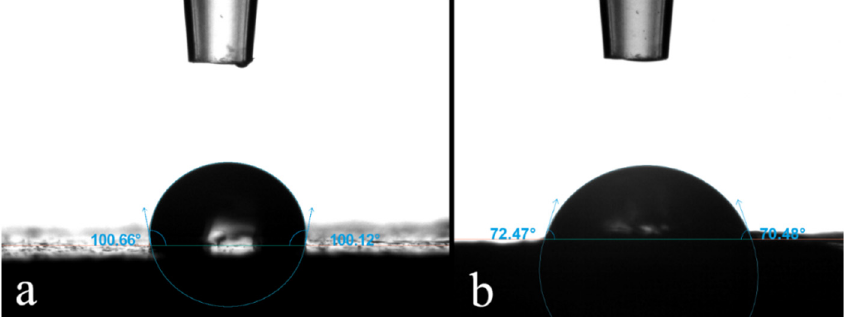
Figure 2. Two examples of CA measurement after drop release. In ( a ) a WPU-R sample, with a high CA, and in ( b ) a WPU-1:3 sample, with a low CA. Blue angles indicate how the instrument extrapolates the data from the images.